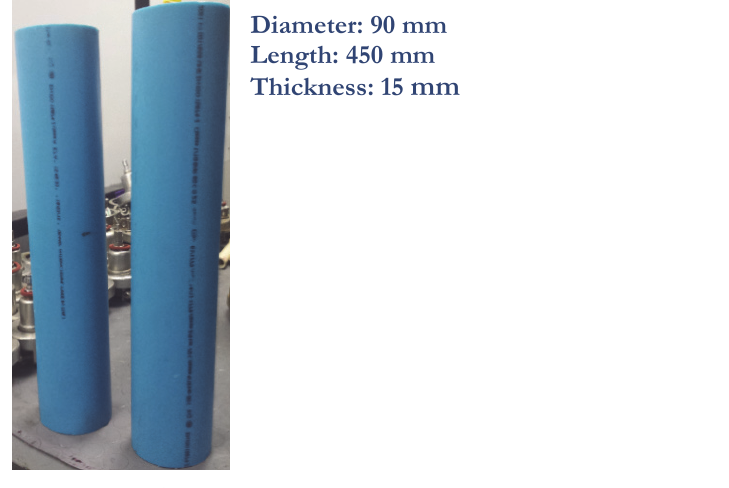
Figure 1: Specimen